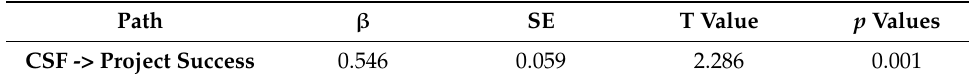
Table 8. Hypotheses and relative paths for the model.